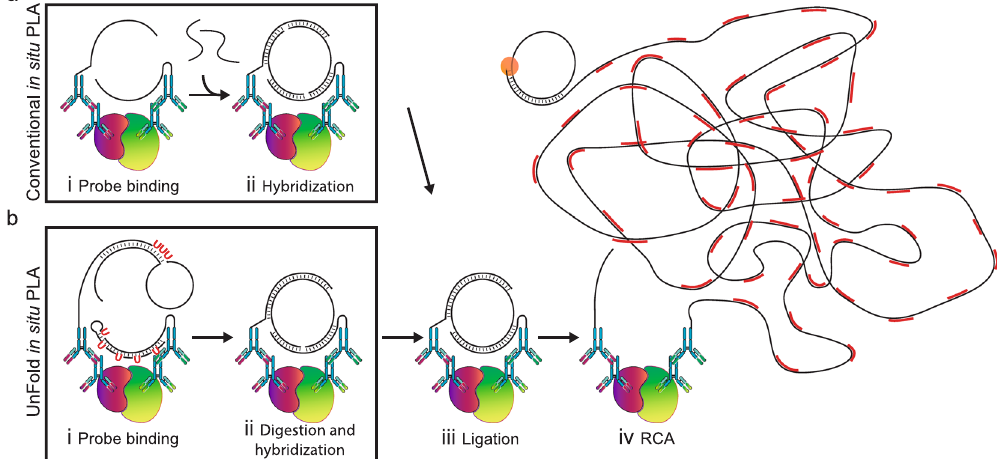
Figure 1. Schematic illustration of in situ PLA using conventional and UnFold probes. ( a ) Conventional in situ PLA. ( b ) In situ PLA using UnFold probes. (i) After pairs of primary antibodies have bound a pair of interacting proteins (red and green) followed by washes, secondary conventional or UnFold in situ PLA probes are added, followed after an incubation by renewed washes. (ii) In the conventional design under ( a ) two more oligonucleotides are then added that can form a DNA circle. Using the UnFold design in ( b ) the probe carrying a hairpin-loop oligonucleotide is cleaved at the U residues, liberating a free 5 ′ end capable of being ligated to the 3 ′ end of the same DNA strand. Meanwhile, the U residues in the hairpin DNA strand of the other UnFold probe are cleaved presenting a single-stranded template for the enzymatic joining of the ends of the strand on the first UnFold probe. (iii) A DNA ligase is added to form DNA circles in the two variants of in situ PLA. (iv) Finally, phi29 DNA polymerase is added to initiate RCA primed by oligonucleotides on one of the antibodies, and fluorescent oligonucleotides are used to visualize the RCA